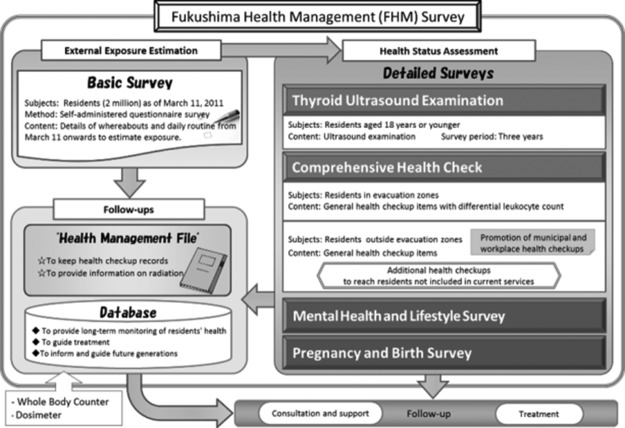
Framework of the FHMS (excerpted from(1)).